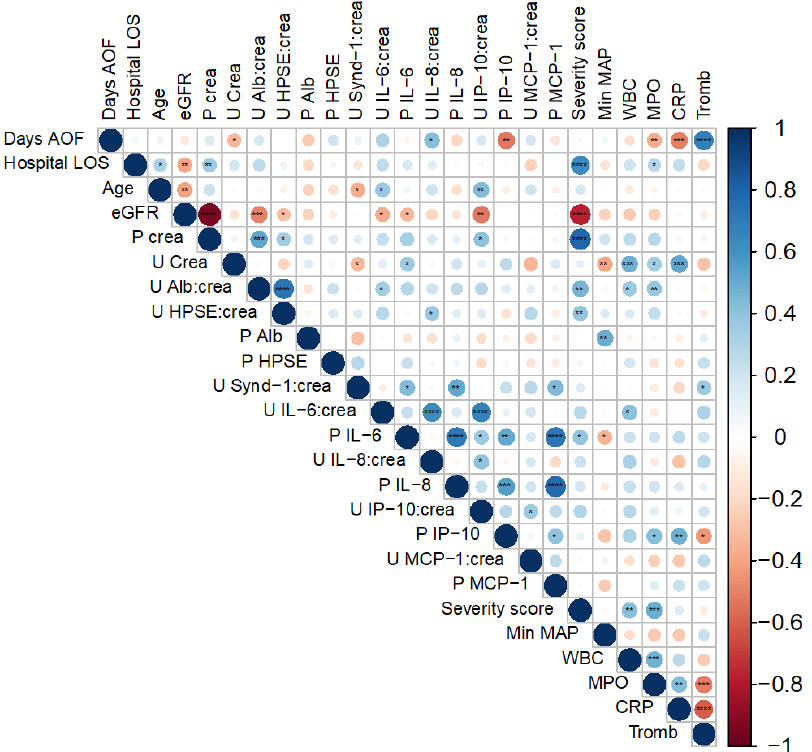
Figure 2. Spearman’s rank correlation coefficient matrix. The colors of the round circles indicate the level of the correlation coefficient and increasing size with a lower p –value. Statistical significance is specified as * = p < 0.05, **= p < 0.01, ***= p < 0.001, ****= p < 0.0001. AOF = after onset of fever, LOS = length of stay, eGFR = estimated glomerular filtration rate, P = plasma, U = urine, crea = creatinine, alb = albumin, HPSE = heparanase, Synd–1 = syndecan–1, IL = interleukin, IP–10 = interferon gamma–induced protein 10, MCP–1 = monocyte chemoattractant protein 1, min MAP = minimum mean arterial pressure, WBC = white blood cells, MPO = plasma myeloperoxi- dase, CRP = plasma C–reactive protein, tromb = blood